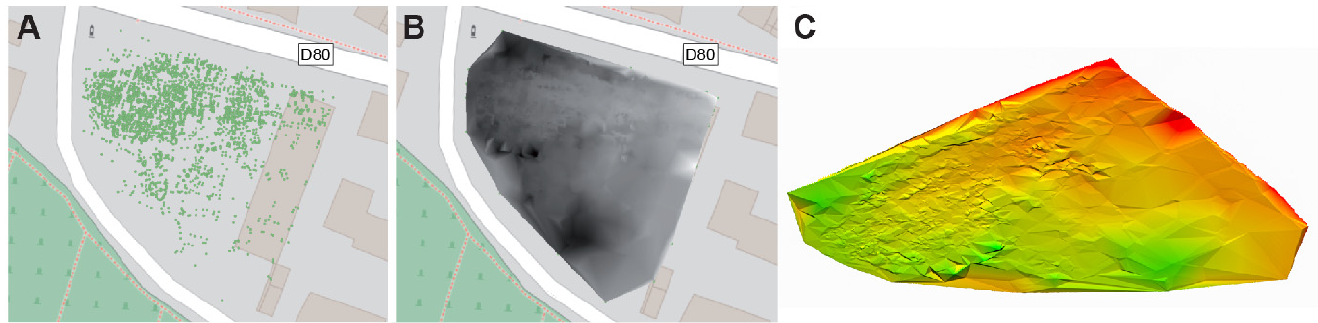
Figure 2. Process of creating the numerical “bottom of form” field model from survey points. ( A ) survey point recorded in the field; ( B ) raster generated from survey points; ( C ) 3D model.